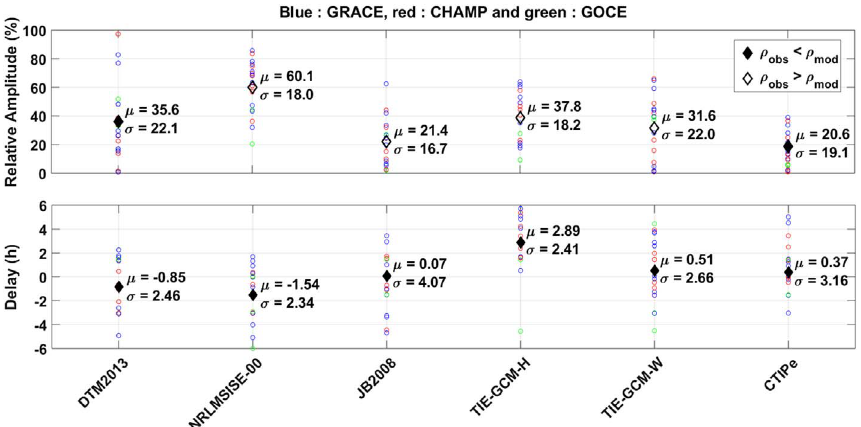
Fig. 7. The absolute relative amplitude difference (top) and the modeled minus observed delay in time with respect to the maximum density peak, i.e. negative values mean that the model peaks too early (bottom) for 11 storms, using data from three